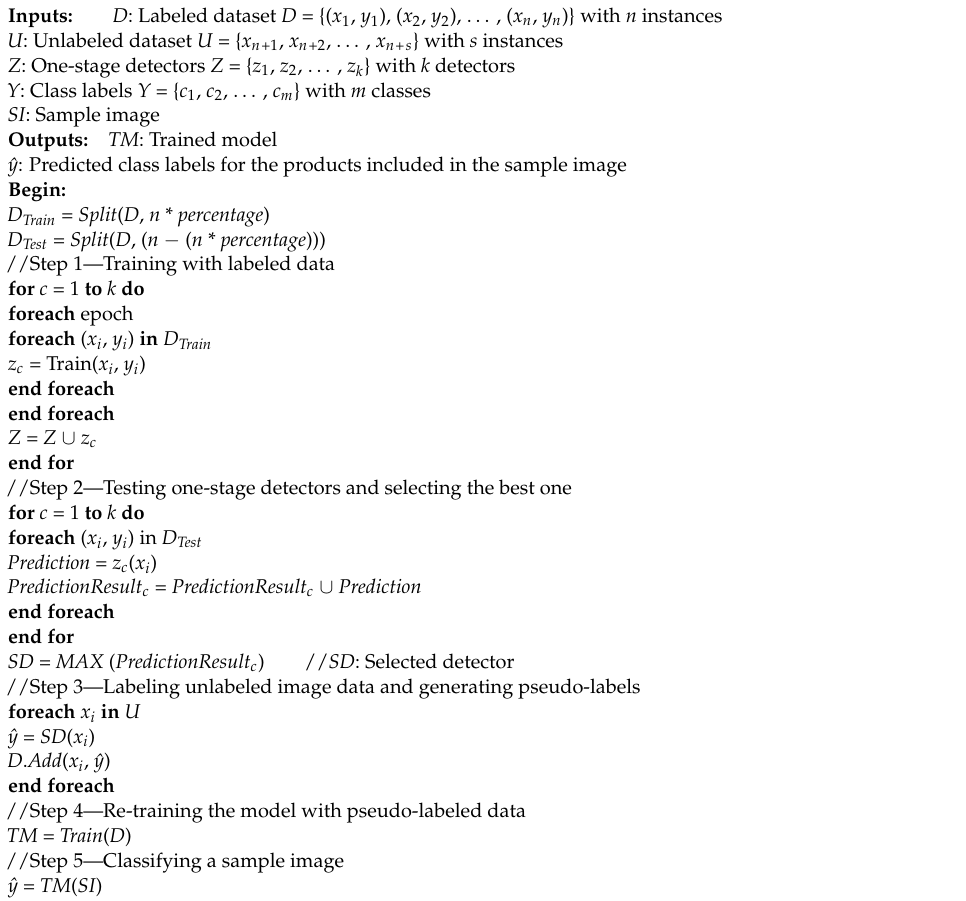
Algorithm 1 SOSA: Semi-Supervised Learning on